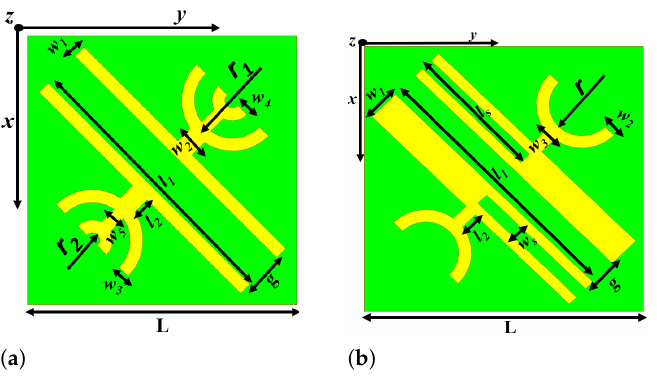
Figure 11. Schematic of multi broadband polarisation converters ( a ) Dual-band PC ( b ) Triple band PC. Table 3. Designed Parameters of the Proposed Dual Broadband Polarisation Converter.